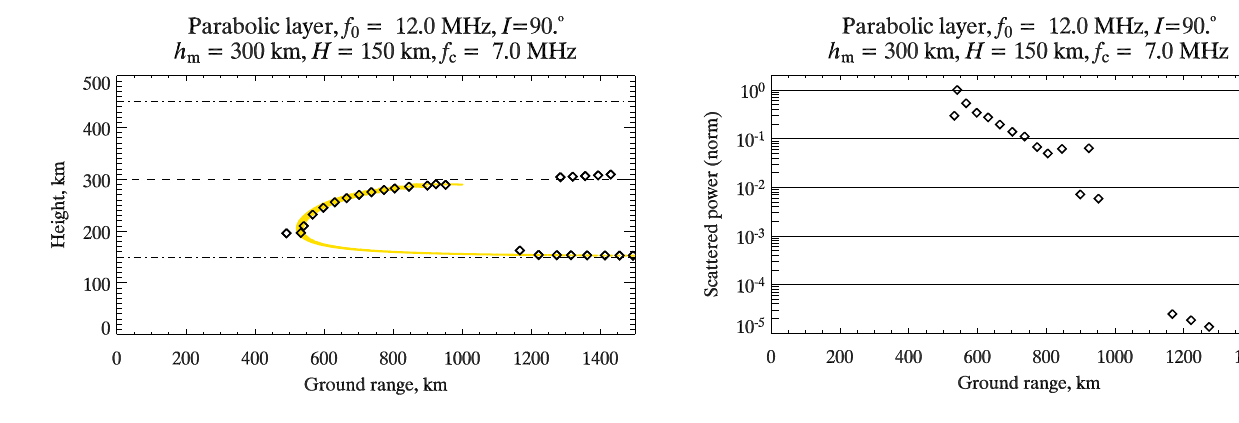
Fig. 4. Scattered power vs. range for the simulated data in Fig. 1 normalised by its maximum